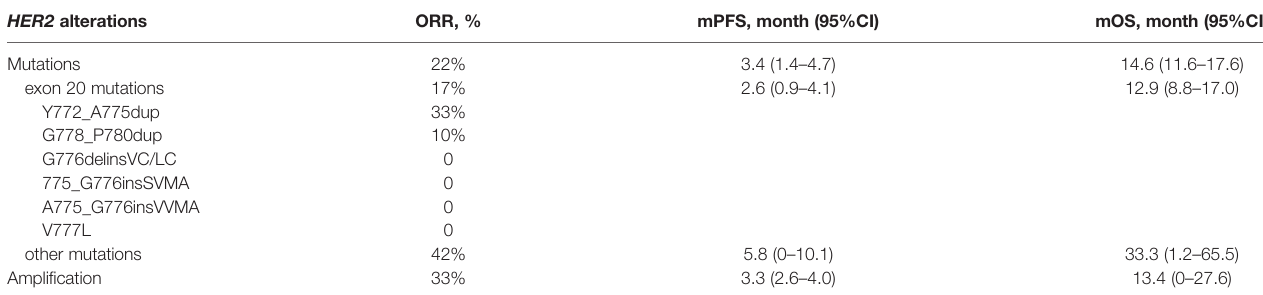
TABLE 3 | Clinical Activity of Afatinib according to HER2